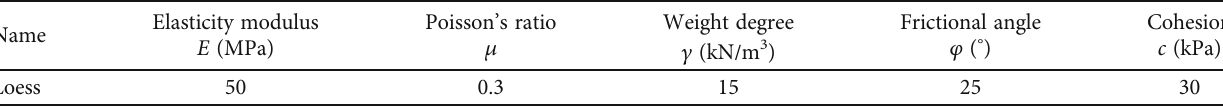
Table 2: Loess material parameter values for simulation.